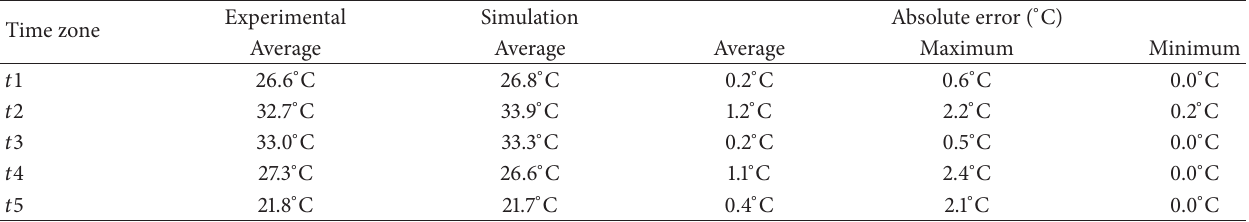
Table 5: Average temperature and absolute error for the middle point of concrete with graphite/PCM.